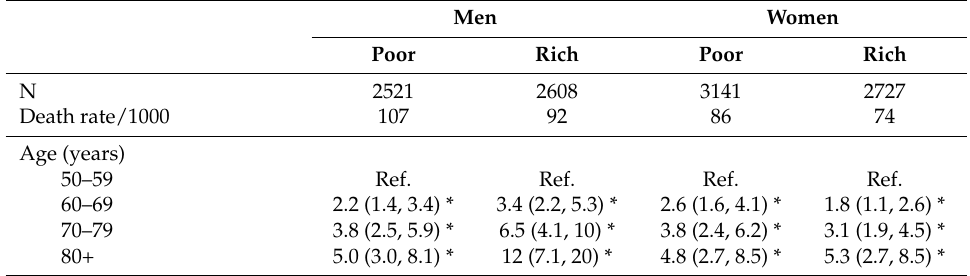
Figure 3. Plots of mortality hazard ratio (HR) with 95% confidence interval (shaded regions) from multivariate adjusted Cox regression analysis with restricted cubic splines of waist circumference. WHO-INDEPTH SAGE Purworejo longitudinal data (2007–2010).